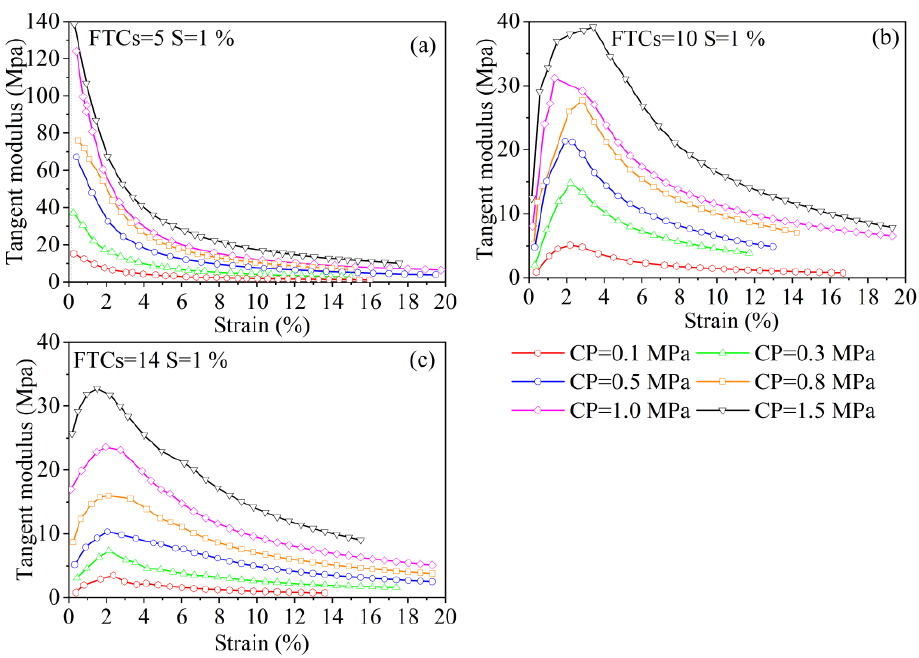
Figure 6. Tangent modulus E f for different freeze–thaw cycles with a salinity of 1% at different confining pressures. Notes: FTCs represents freeze–thaw cycles, S represents salinity, and CP represents confining pressure.